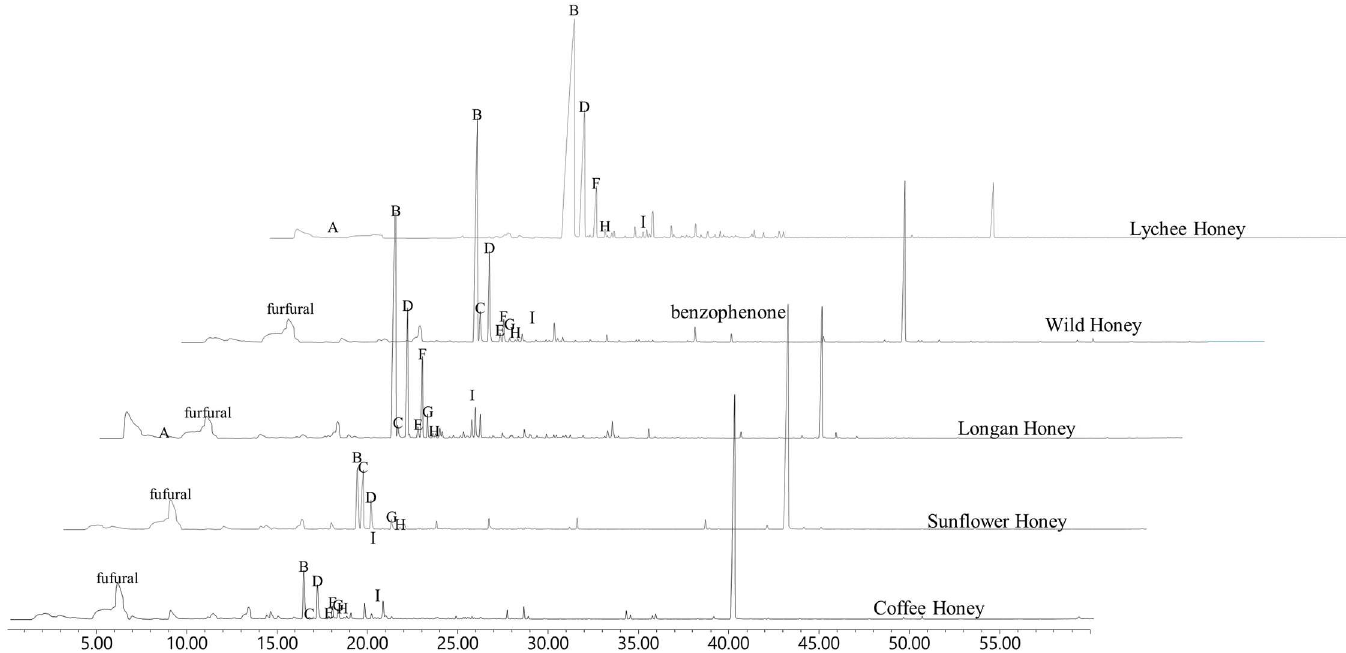
Fig 1. Representative chromatograms of Thai honeys on HP-5MS column. A: isoamyl alcohol.B: c is -linalooloxide. C: 2,5-furandicarboxaldehyde. D: trans -linalool oxide. E: linalool.F: ho-trienol.G: benzyl ethanol. H: isophorone.I: